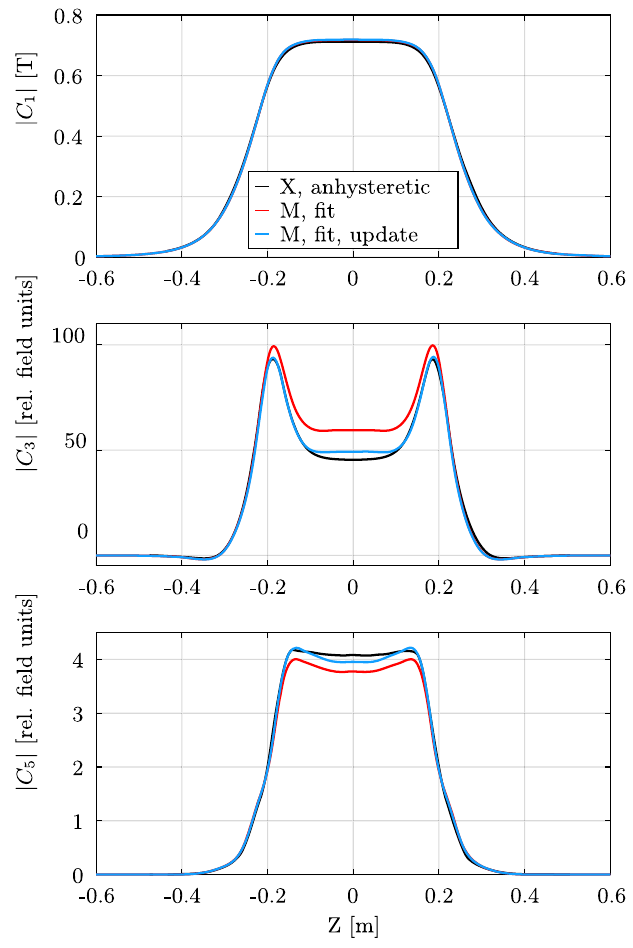
FIG. 7. Multipole profile on magnet axis, from validation measurements. A small rotating coil scanned the magnet on its axis, with r 0 ¼ 18 mm. j C 3 j and j C 5 j are given in relative field units , which is the magnitude of the multipole at r 0 , divided by the main component j C 1 j and multiplied by 10 4